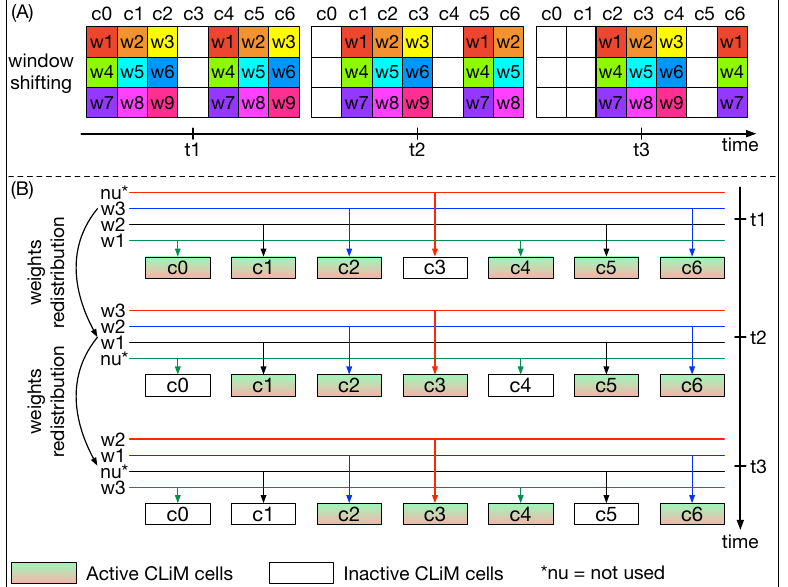
Figure 14. ( A ) Convolution windows are shifted over the array by properly activating/inactivating rows and columns. ( B ) The weight dispatcher properly distributes weights inside the CLiM array in order to reproduce the convolution window shifting